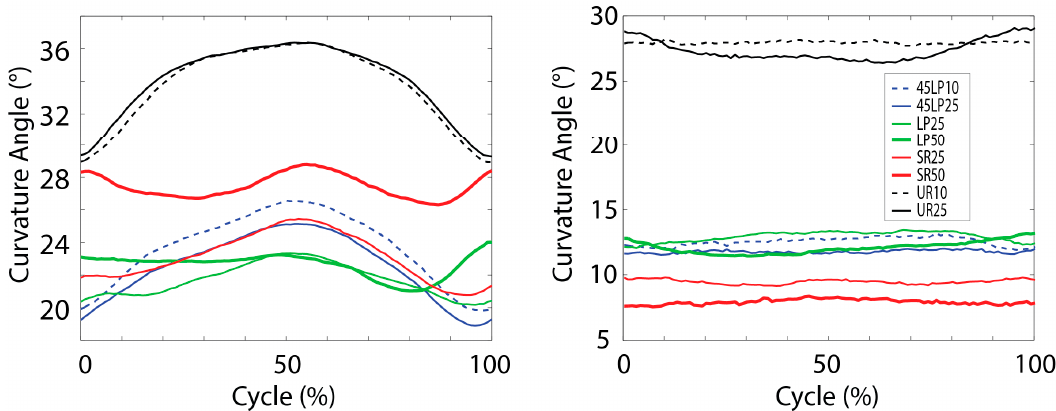
Figure 1. Mean curvature angle in the thoracic ( left ) and lumbar ( right ) region over one cycle averaged for all subjects.